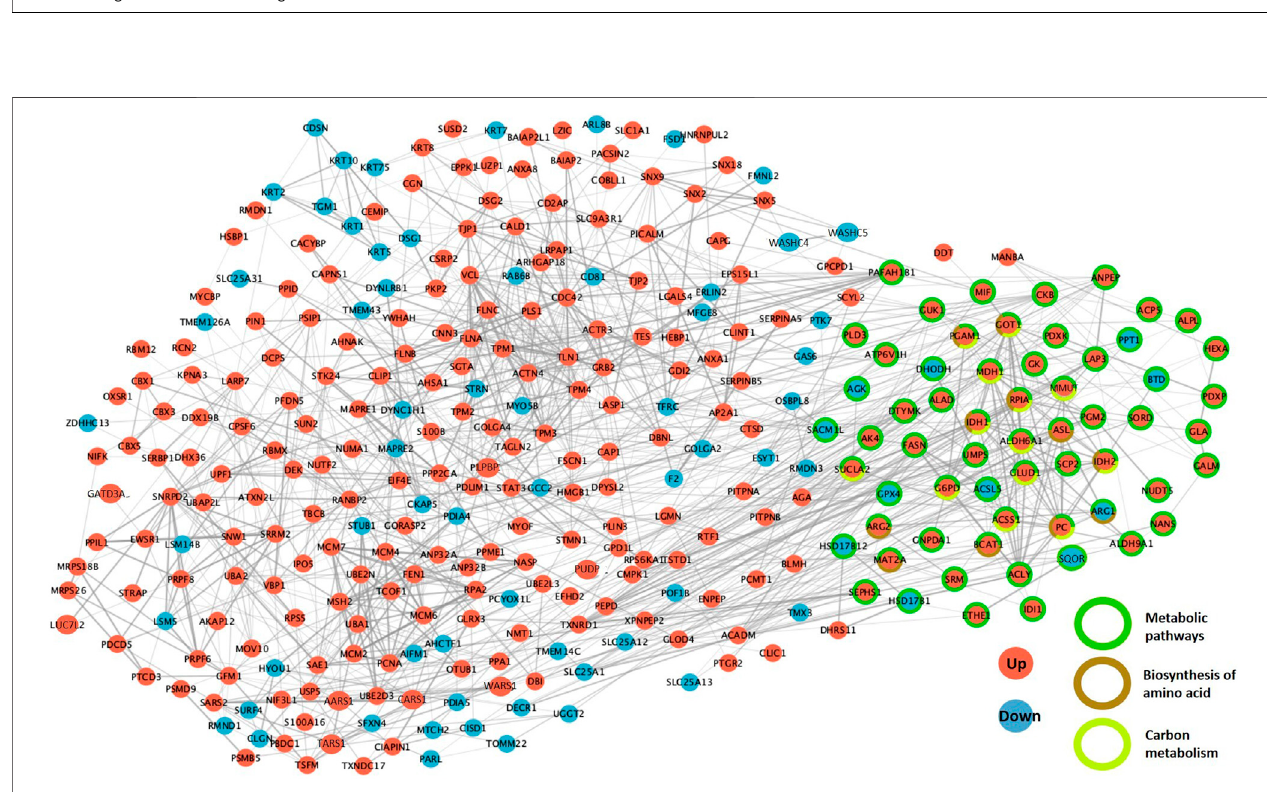
FIGURE 10 | Protein-protein interaction networks between differentially abundant proteins (DAPs) during the compact morula-to-blastocyst transition. The PPI networkwasbuiltusingSTRINGandCytoscape.DAPsincreasedinabundancebetweenthecompactmorulaandblastocyststagesareinredwhileproteinsdecreased in abundance are in blue. The DAPs involved in the three most signi fi cant KEGG pathways are indicated by colored circles in green, brown and yellow.